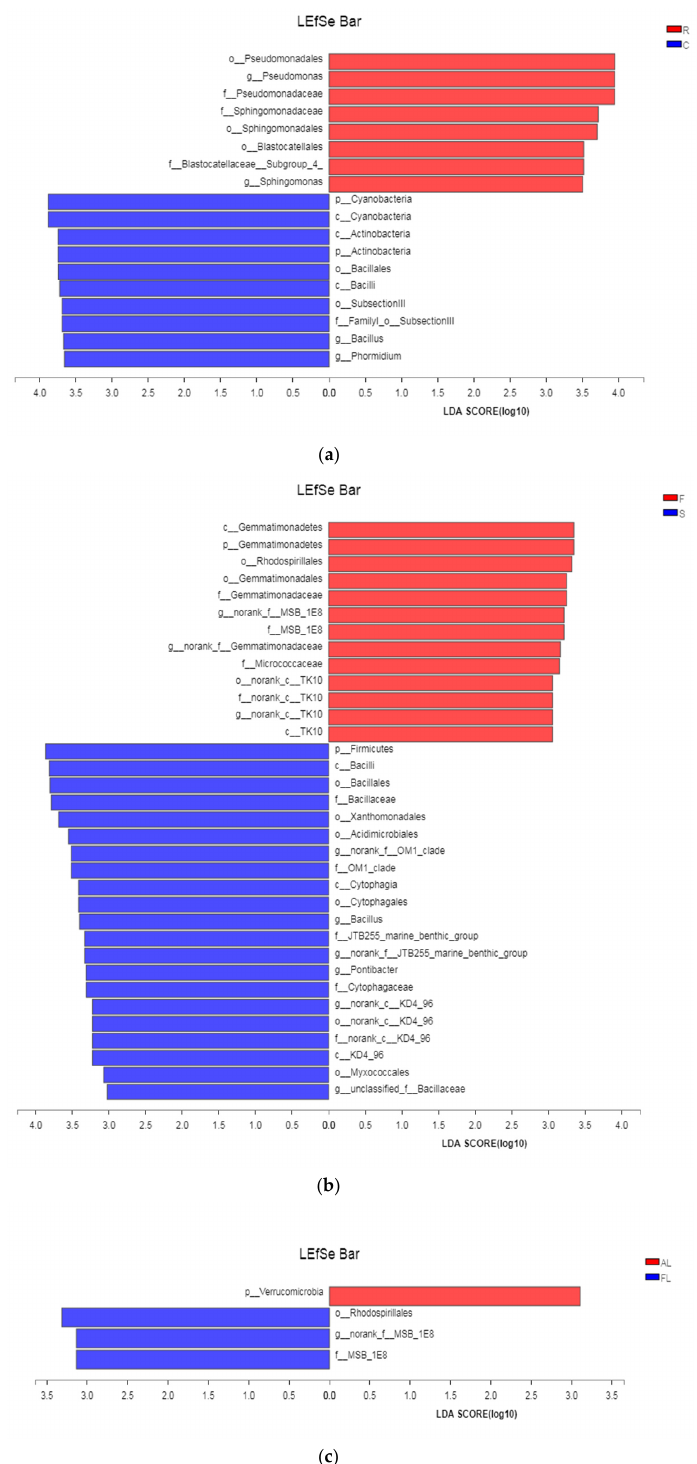
Figure 3. Linear discriminant analysis Effect Size (LEfSe) results of bacterial taxa in soils irrigated with different water types ( a ), irrigation technologies ( b ), and methods ( c ). The linear discriminant analysis (LDA) scores derived from LEfSe analysis, showing the biomarker taxa (LDA score of >3.0 and a significance of p < 0.05 determined by the non-parametric factorial Kruskal–Wallis (KW) sum-rank test). R and C represent reclaimed water-irrigated and clean water-irrigated soil samples, respectively. F and S represent furrow-irrigated and subsurface drip-irrigated soil samples, re- spectively. AL and FL represent alternate partial root-zone irrigated and Full-irrigated soil sam- ples, respectively. Under different irrigation techniques, five groups were most strongly associated with FUI, namely Rhodospirillales , MSB_1E8_f_norank (from family to genus), Gemmati-